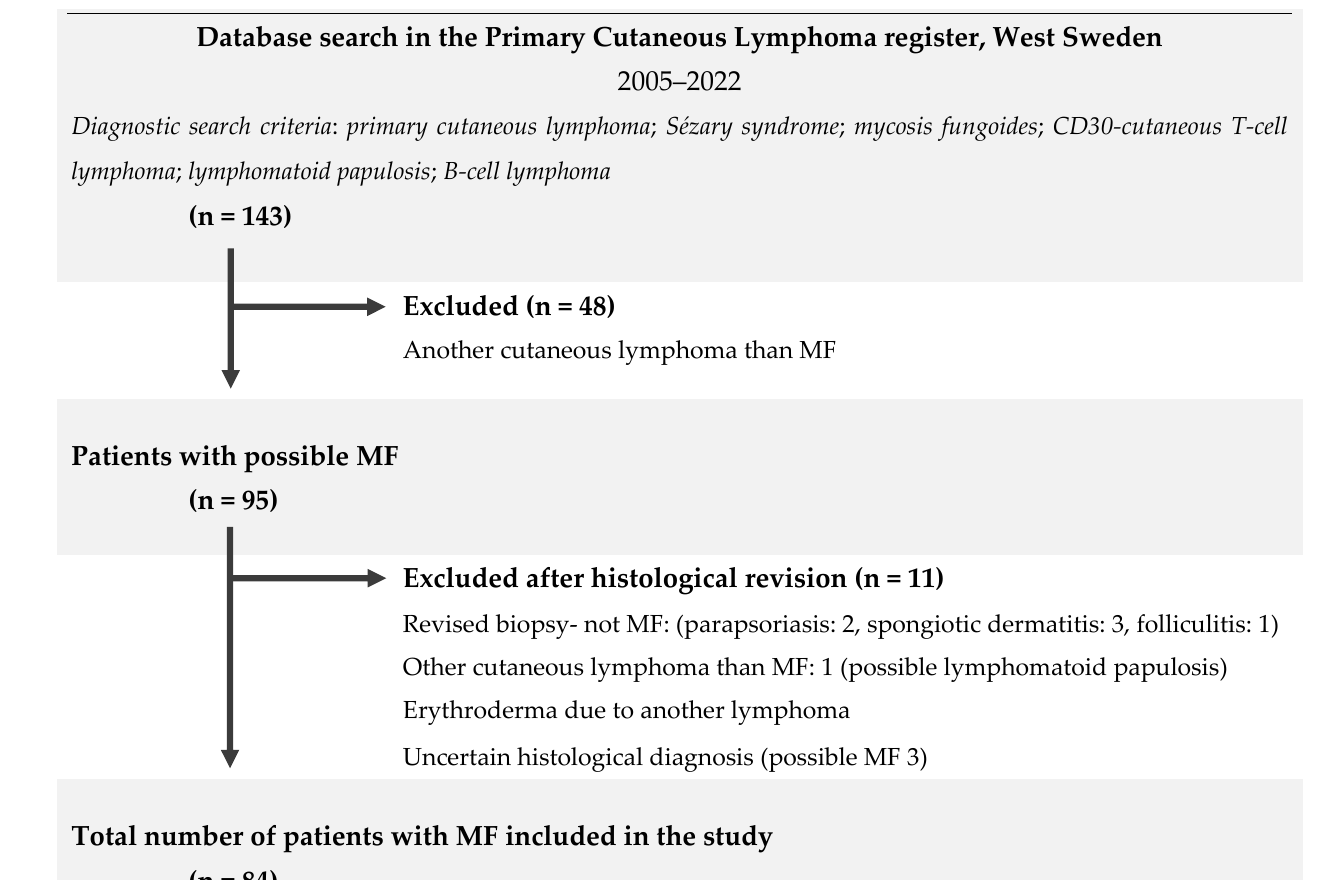
Figure 2. Flowchart of the applied inclusion and exclusion criteria. CD: cluster of differentiation; n: number; MF: mycosis fungoides.